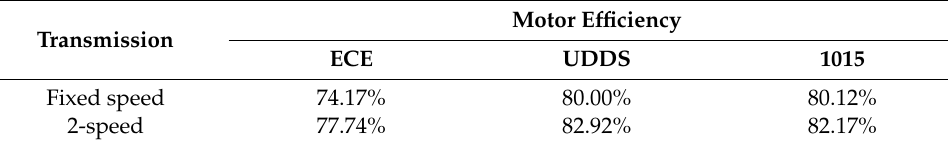
Figure 15. Motor operating point comparison (1015). ( a ) Fixed ratio transmission. ( b ) Two-speed planetary transmission. Table 5. Motor efficiency comparison.